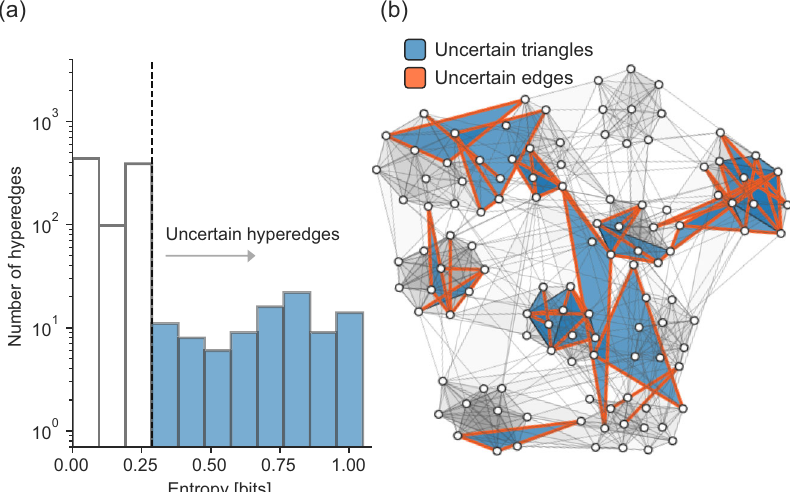
Fig. 6 Uncertain higher-order interactions uncovered in the network of American football games. a Distribution of the entropy for the presence/absence of hyperedges. The entropy quanti fi es the variability of hyperedges: sets of nodes that are connected in nearly all — or almost none — of the samples have low entropy. We deem as uncertain a hyperedge that has a probability p ∈ [ α , 1 − α ] of being present, with α = 0.05. Note that we only show the entropy for the sets of nodes that were connected at least once in our Monte Carlo samples; a large number of hyperedges, of entropy zero, are never seen in our samples. b Visualization of the uncertain hyperedges. Uncertain edges are highlighted in orange and uncertain triangles are shown in blue. Remaining uncertain interactions are shown in gray. All results are computed with 4000 Monte Carlo samples from the posterior distribution each separated by 1000 complete sweeps of the factor